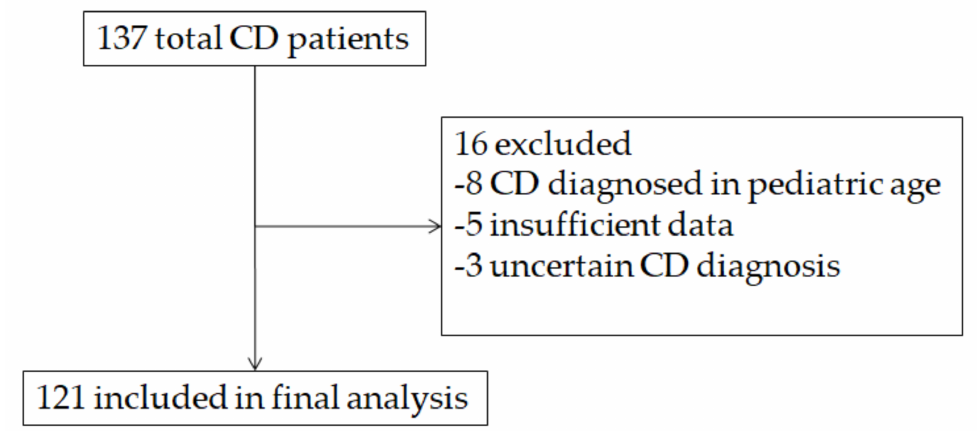
Figure 1. Flowchart of patients